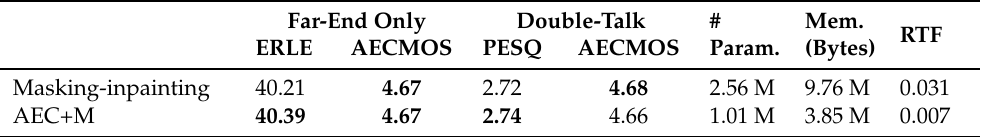
Table 5. Comparison of the proposed masking architecture without the DTD (AEC+M) and the masking architecture in